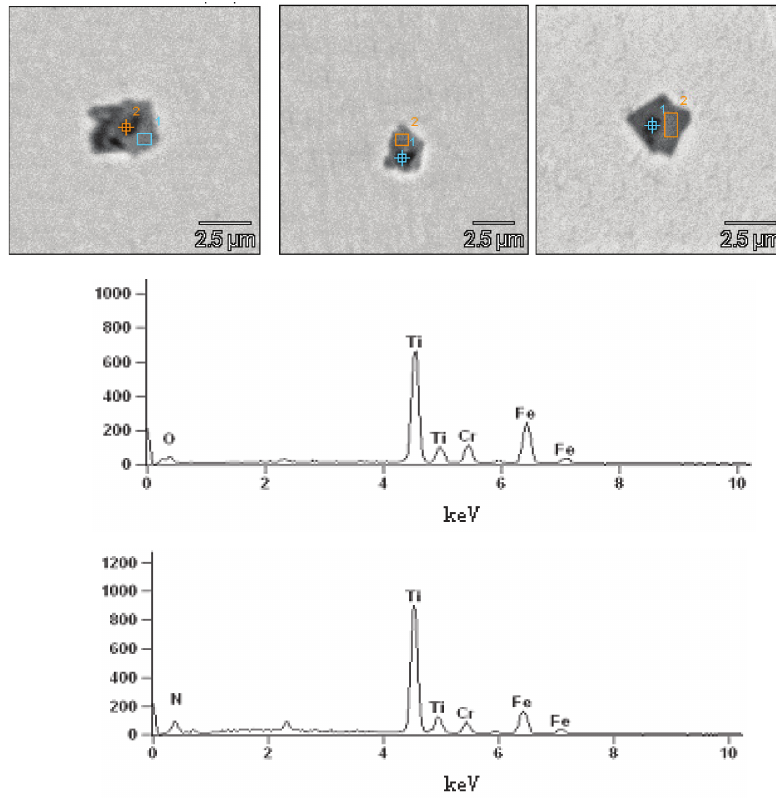
Figure 5: Two-dimensional morphology of composite core and energy spectrum. (a) Energy spectrum of the darker part in the centre of core. (b) Energy spectrum of the pale part in the outer of